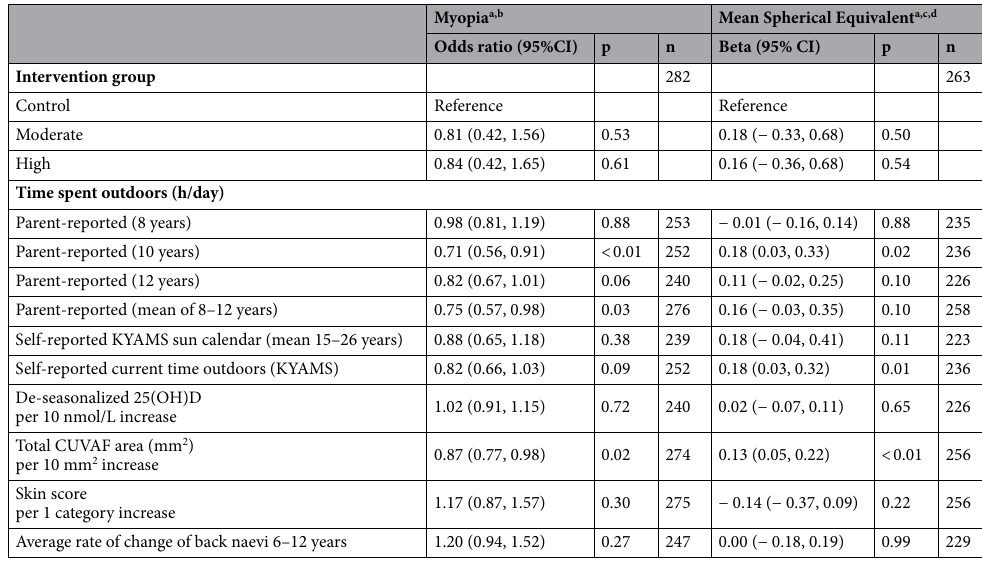
Table 3. Associations between myopia or spherical equivalent and individual measures of time spent outdoors using multivariable regression. 25(OH)D 25-hydroxyvitamin D, CUVAF conjunctival ultraviolet autofluorescence. a Adjusted for age, sex, university education, outdoor occupation, parental myopia, parental education, Caucasian/non-Caucasian race and Kidskin Study intervention group. b Logistic regression. c Linear regression. d 18 participants missing post-cycloplegic spherical equivalent data (n = 11) or had prior refractive surgery (n = 7) and data from 3 participants with moderate- to high-hyperopia excluded as outliers.